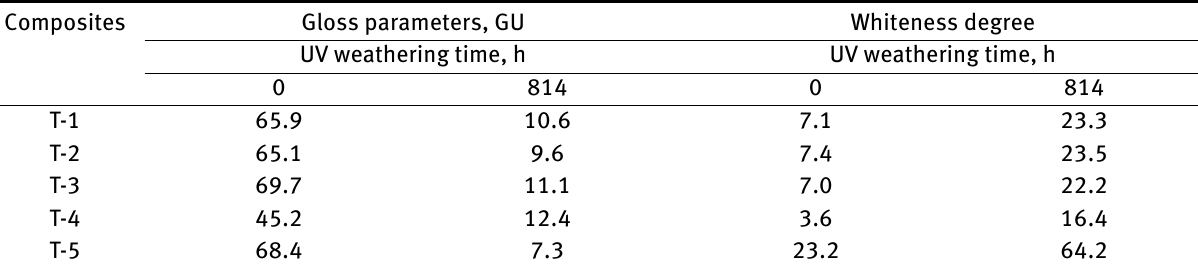
Table 4: The gloss of the surface and whiteness degree of the samples before and after the UV weathering. Composites